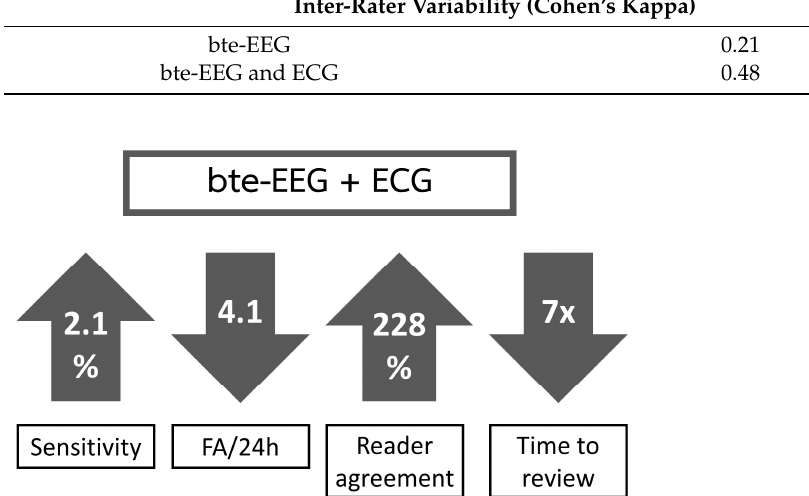
Figure 3. Diagram representing the gain in sensitivity, inter-rater agreement, and reduction of false alarms by reviewing the data with the semi-automated multimodal framework (bte-EEG and ECG) compared with the unimodal framework (bte-EEG). The reduction in the time to review is compared with the reported time to review 24 h of bte-EEG recordings without automated assistance.